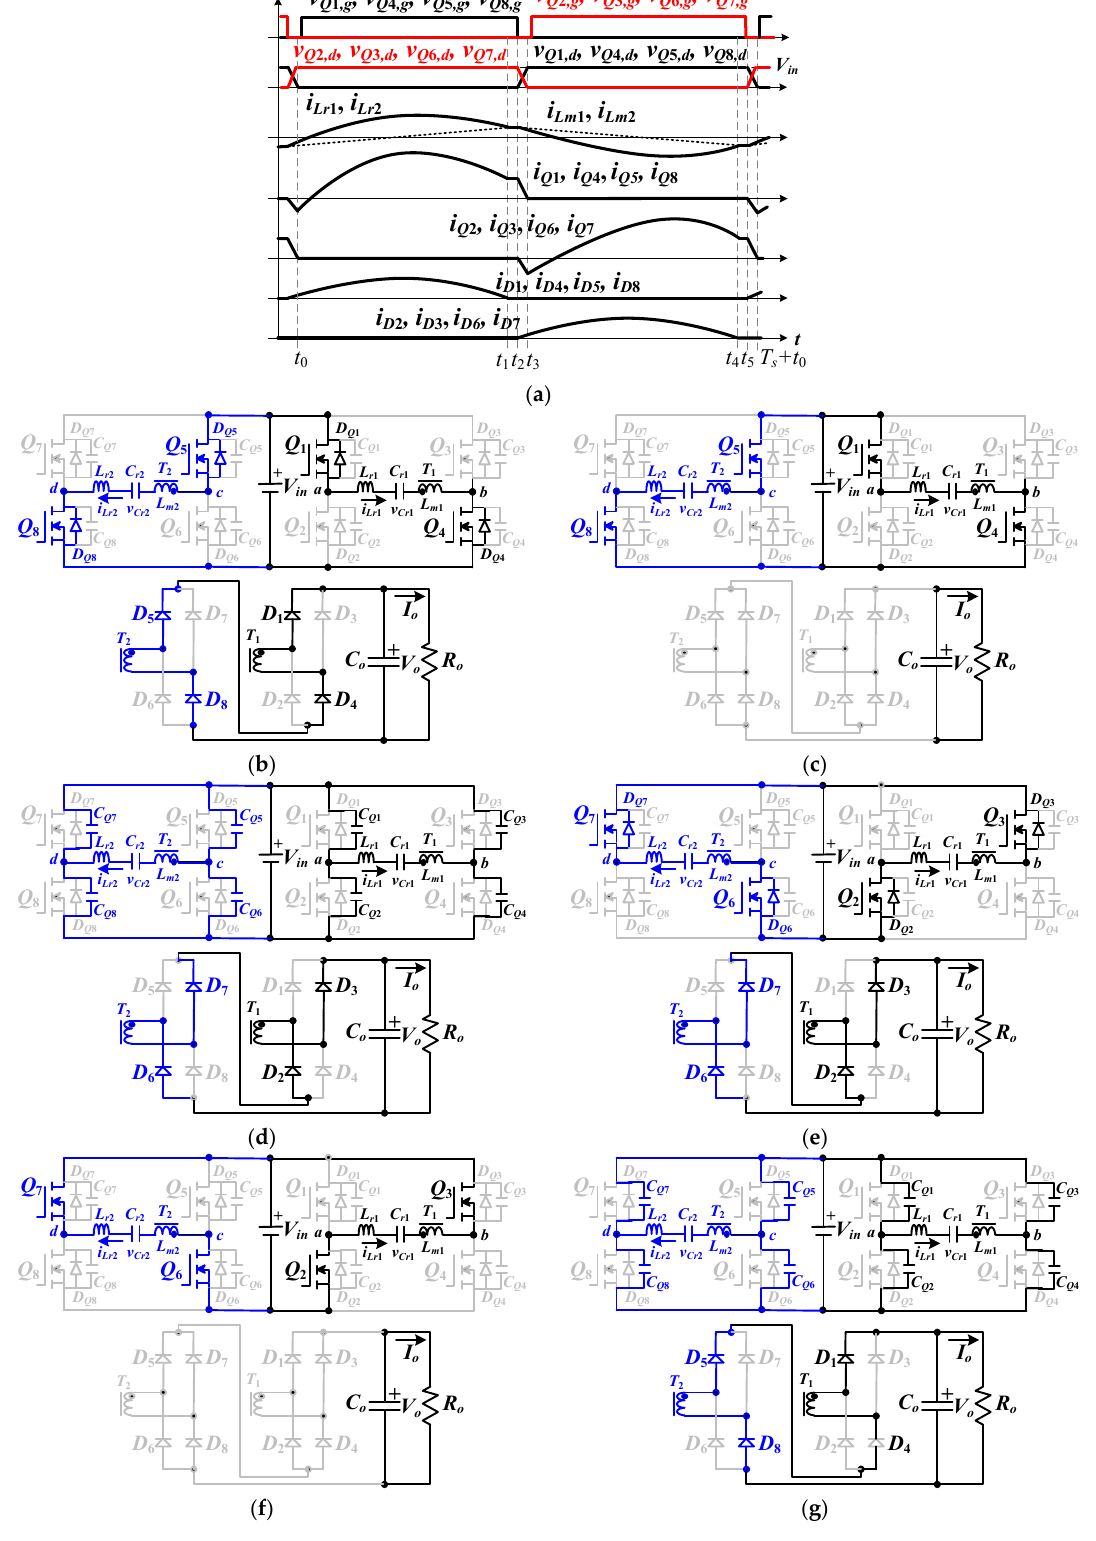
Figure 3. Circuit waveforms and equivalent circuits at low input voltage range and f s < f r, ( a ) PWM waveforms, ( b ) step 1, ( c ) step 2, ( d ) step 3, ( e ) step 4, ( f ) step 5, ( g ) step 6. 2.2. Under High Voltage Input Range (V in = 200 V ~ 400